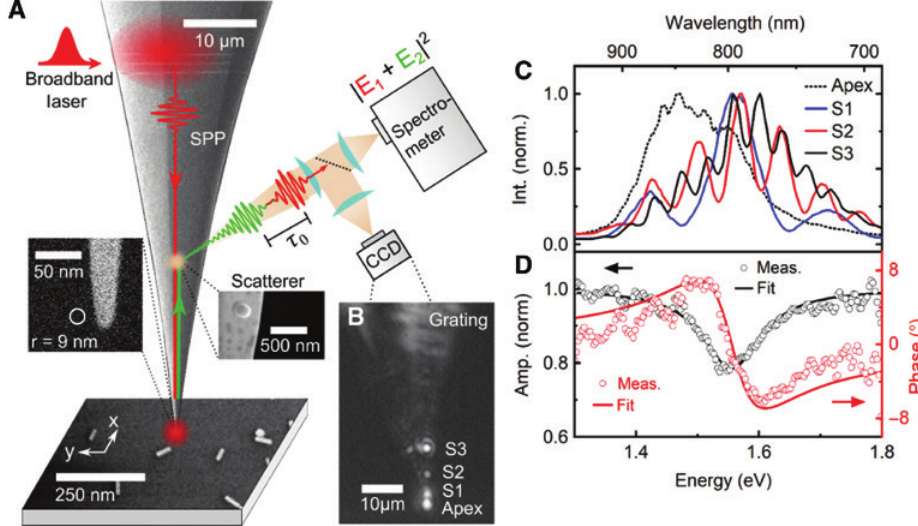
Figure 1: Plasmonic nanofocusing spectral interferometry (PNSI) of individual gold nanorods. (A) Broadband laser radiation is grating-coupled to SPPs on the shaft of a conical gold taper. The SPPs are nanofocused to a 10-nm-sized light source at its apex (left inset), locally exciting individual gold nanorods. The field emitted by the nanorod couples back to the apex, launching a secondary, backpropagating SPP field (green arrow). Protrusions of ~ 100 nm size on the shaft (right inset) scatter both the incident SPP field E and the time-delayed backpropagating field E into the far field, generating a spectral interferogram (SI) on the detector. (B) Side view 1 2 of the gold taper showing light scattering from the apex and three additional scatterers (S1–S3). (C) SIs recorded by selectively collecting the light scattered from S1, S2, and S3, together with the apex spectrum (dashed line). The spectra from the scatterers show a pronounced spectral modulation with a fringe spacing that decreases with the apex-scatterer distance, i.e. with increasing time delay τ . (D) Amplitude (black open symbols) and phase spectrum (red open symbols) of a gold nanorod reconstructed from the SI. The longitudinal E 2 surface plasmon resonance at 1.56 eV is shown, together with fits to a Lorentzian line shape function (solid